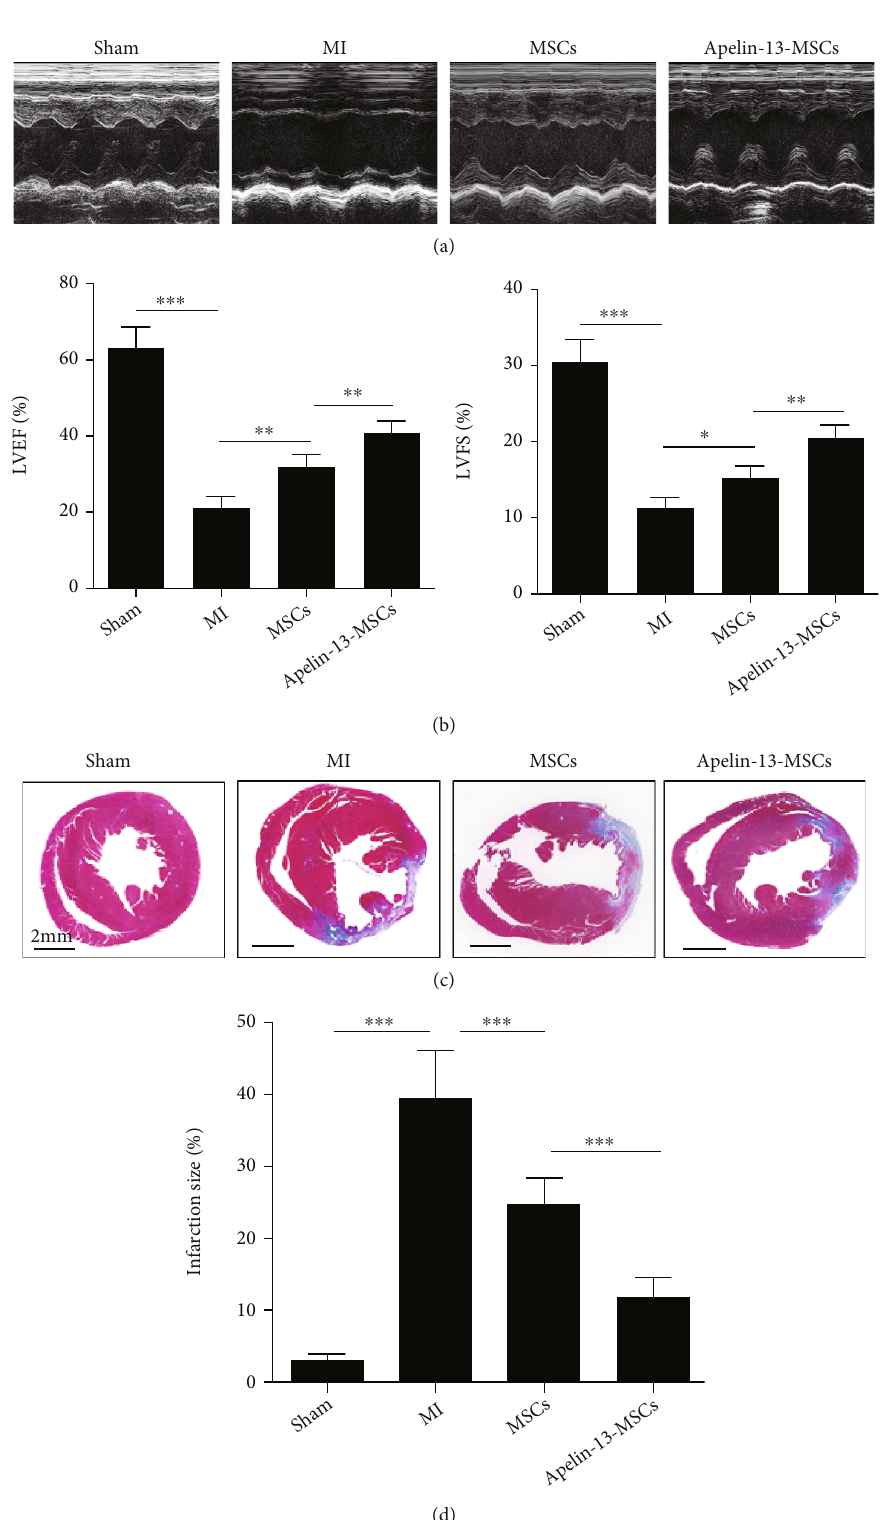
Figure 4: Transplantation of Apelin-13-pretreated MSCs improves heart function following infarction in mice. (a) Representative images of echocardiographic images captured at 4 weeks in mice among the di ff erent groups. (b) Quantitative analysis of LVEF and LVFS at 4 weeks in mice from the di ff erent groups. (c) Representative images of Masson ’ s trichrome staining of heart sections at 4 weeks in mice among the di ff erent groups. (d) Quantitative measurement of heart fi brosis at 4 weeks in mice among the di ff erent groups. n = 6 mice for each group. Data are expressed as mean ± SD . Scale bar = 2 mm . ∗ p < 0 : 05 , ∗∗ p < 0 : 01 , ∗∗∗ p < 0 : 001